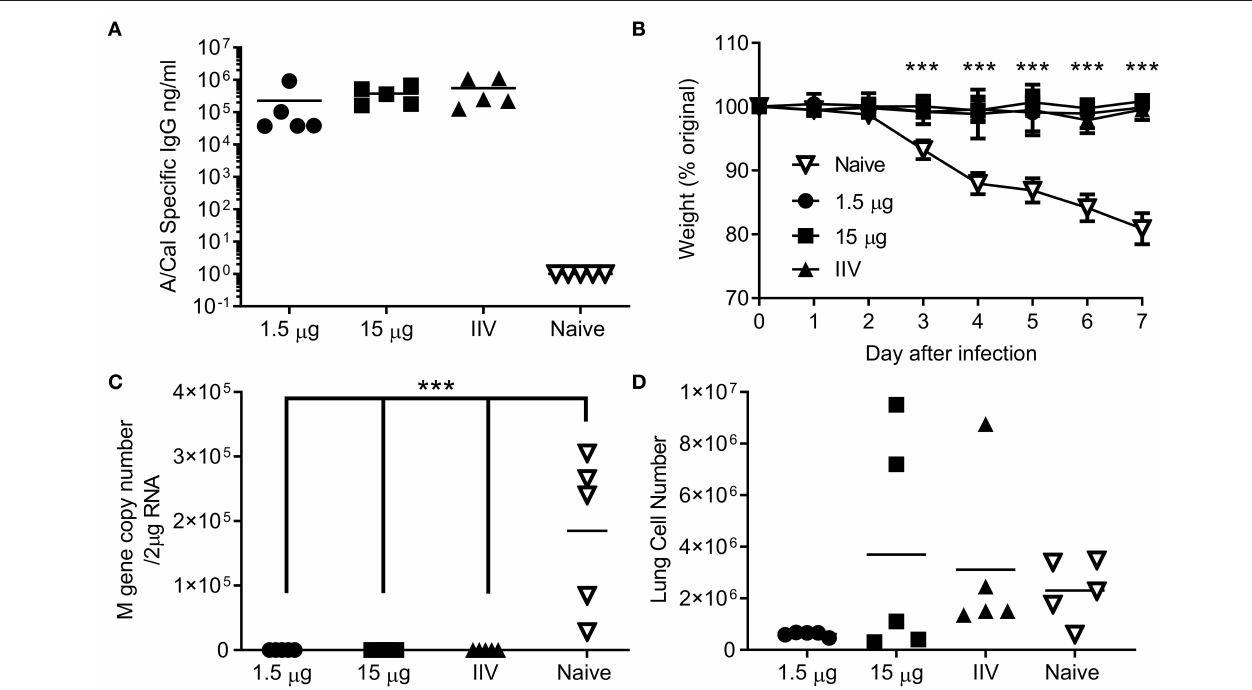
FIGURE 4 | Ciliate produced rHA protects against infection with H1N1 influenza. Mice were immunized three times at 3 weekly intervals with 15 or 1.5 µ g ciliate derived A/Cal, or 15 µ g control inactivated influenza antigen (IIV) by the intramuscular (i.m.) route. Two weeks after the final immunization, anti-H1N1 antibody titer was measured by ELISA (A). Mice were then challenged with pH1N1 by the intranasal route. Weight change (B) , viral load (C) , and lung cell number (D) were assessed after infection. Points represent individual animals (A,C,D) or mean (B) of n = 5 mice per group, *** p < 0.001 by ANOVA and post test.